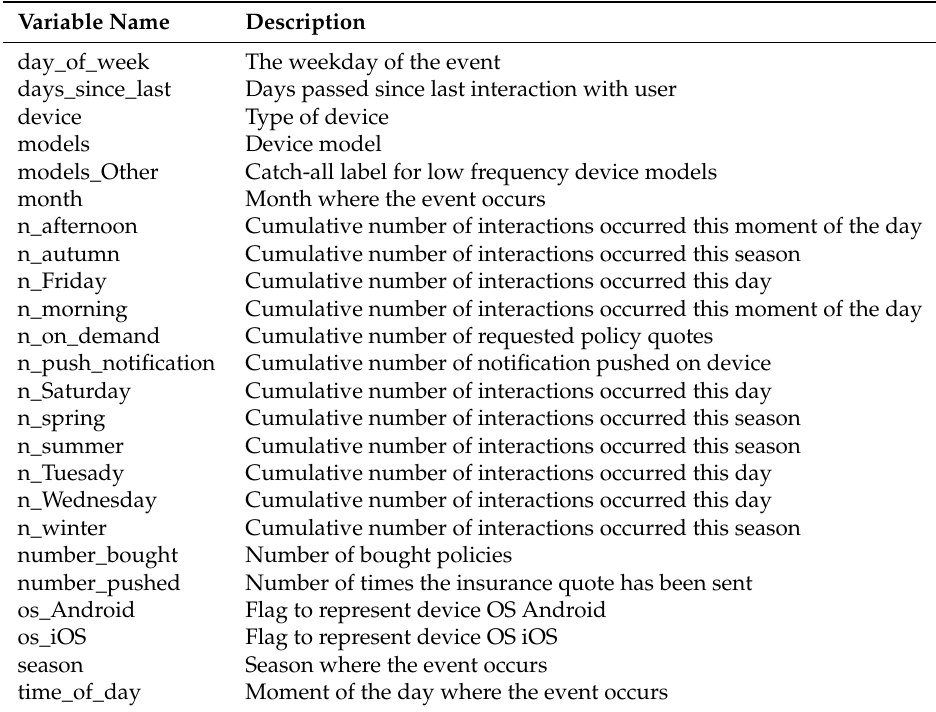
Table A1. Variables’